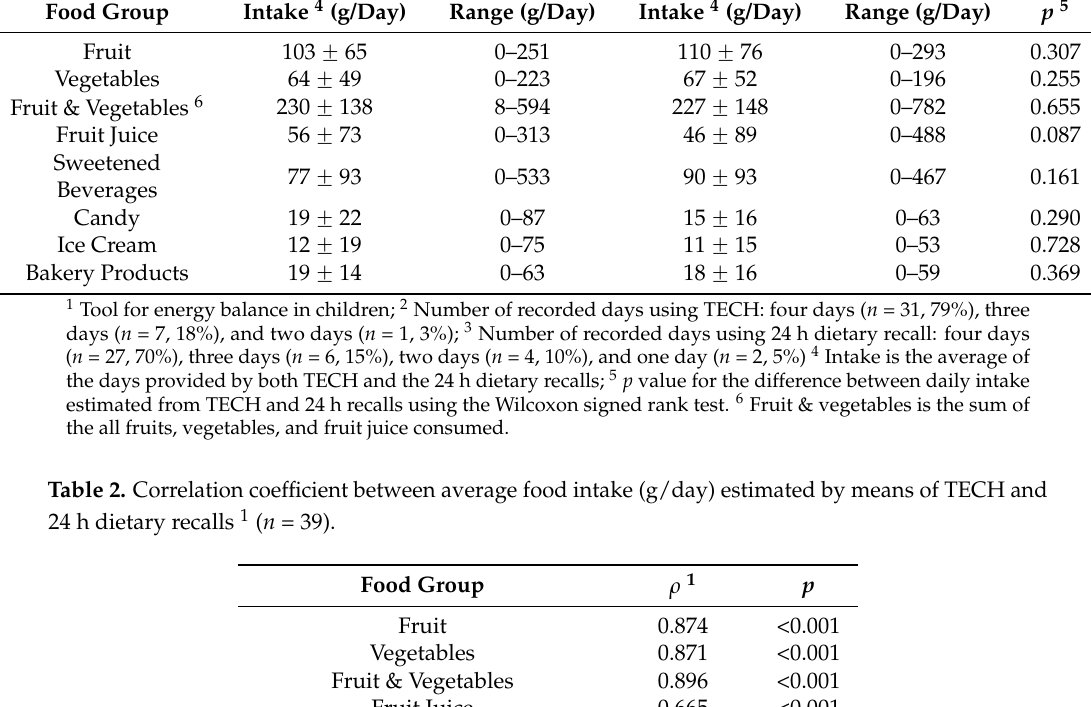
Table 1. Mean intake of foods estimated by means of TECH and 24 dietary food recalls ( n = 39). TECH 1,2 24 h Recall 3